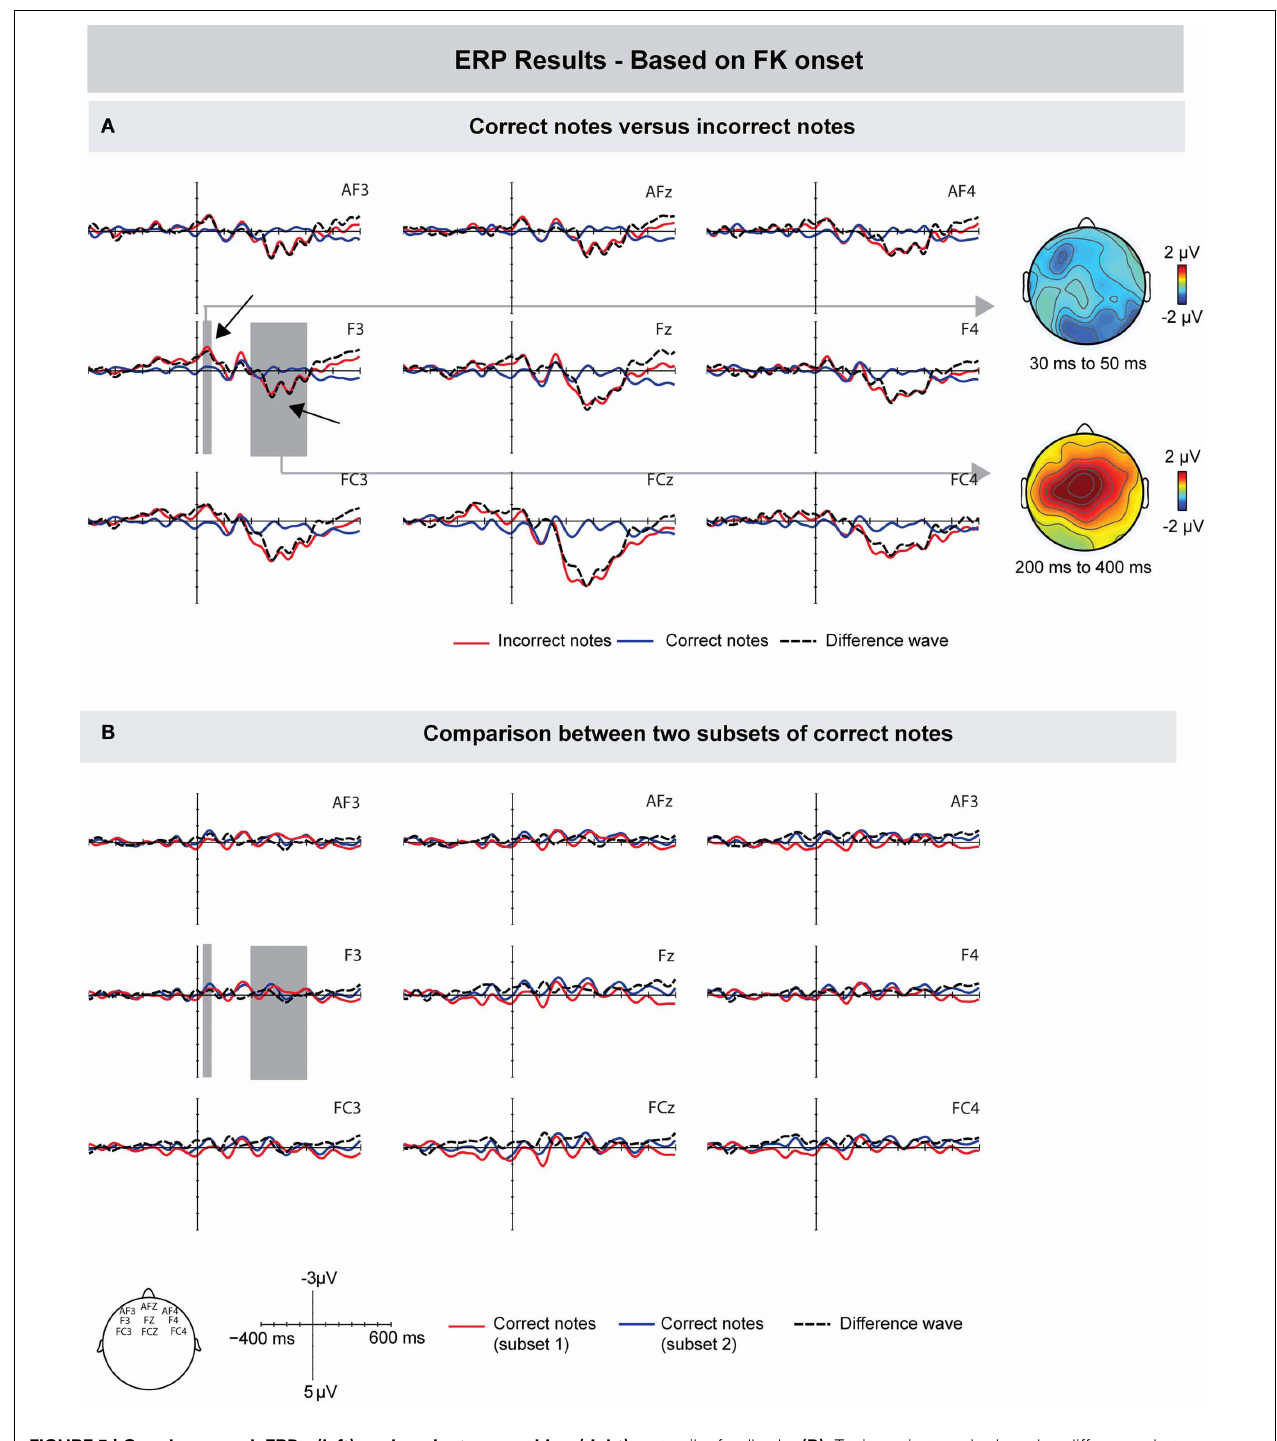
tactile feedback. (B) To investigate whether the difference between correct and incorrect notes is influenced by overlapping ERP responses from previous notes, two subsets of correct notes were compared. ERPs showed marginally significant differences in the time windows used for the comparison of correct and incorrect notes. Therefore, results of the ERPs time-locked to FK onsets can only be tentatively interpreted. Gray areas show the time windows used for statistical analysis, exemplarily on one